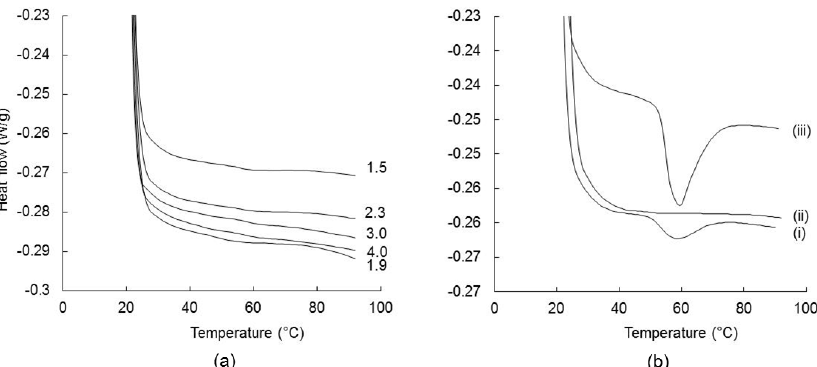
Figure 2. Differential scanning calorimetry (DSC) endotherms for ( a ) unsalted fermented milk–wheat composites (FMWC) with different ratios of fermented milk to wheat: 1.5, 1.9, 2.3, 3.0, or 4.0 as shown; and ( b ) non-parboiled wheat (i), parboiled wheat (ii), and native wheat starch (iii).